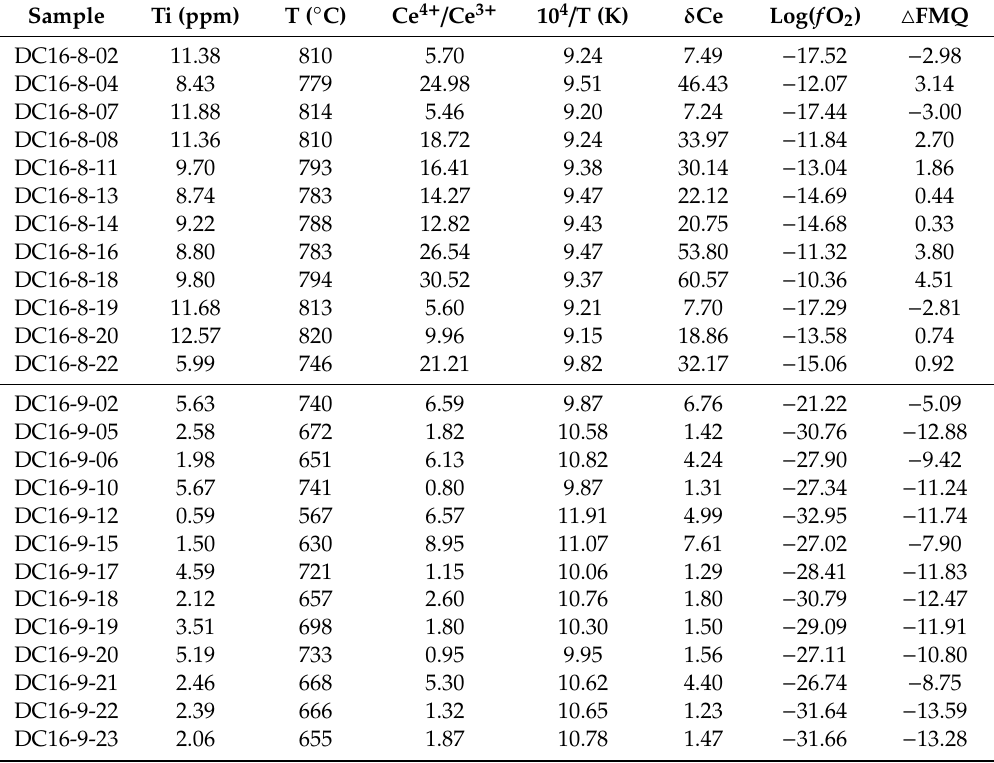
Table 2. Oxygen fugacity data of the granodiorite and MMEs of the Daocheng